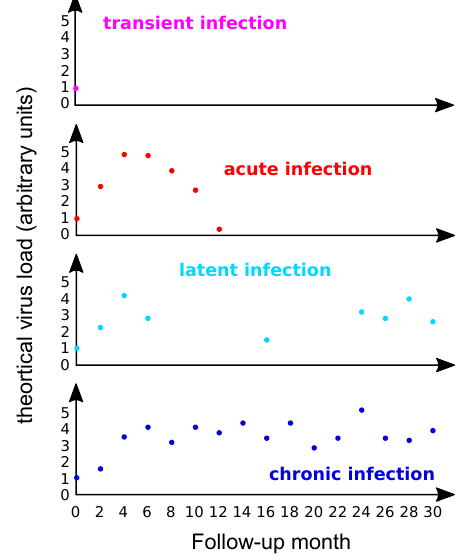
Figure 2. Kinetics of HPV virus load in different genital infections. The panels present made-up data with four imaginary patients monitored every two months from the onset of the infection (month 0). Currently most data describe viral load in precancerous lesions and in cancers [29], while very little data focus on how virus loads vary over the course of an acute